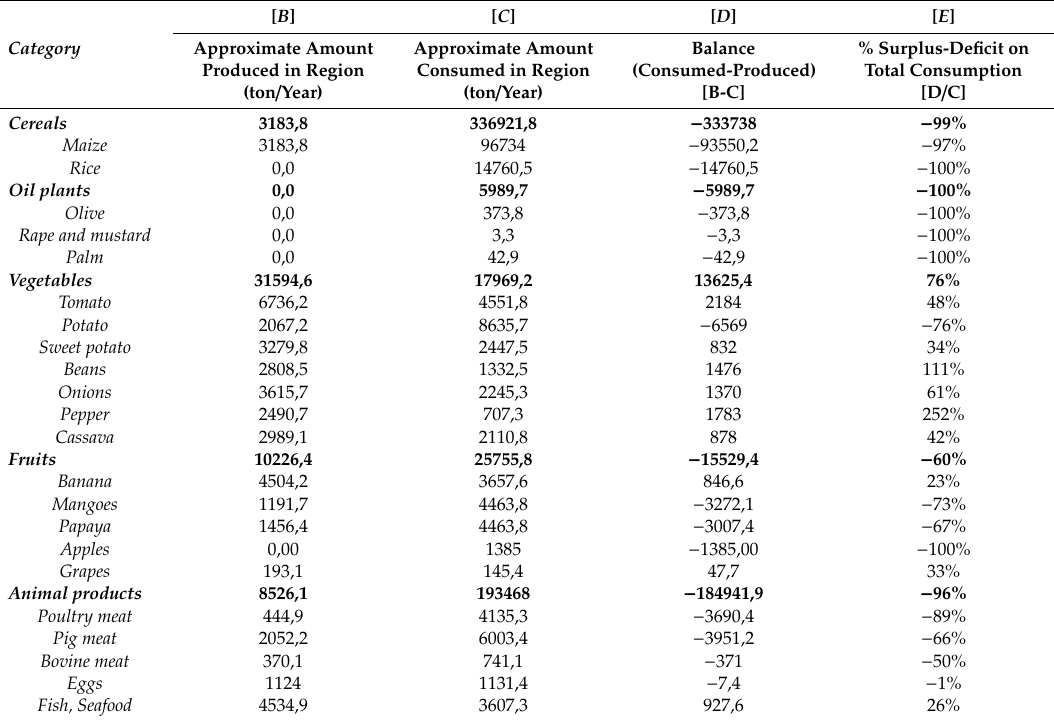
Table 2. Balance of production and consumption of relevant agricultural products in the region. [ B ] Category Balance % Surplus-Deficit on Approximate Amount Approximate Amount Consumed in Region (Consumed-Produced) Total Consumption Produced in Region [D / C] (ton / Year) (ton / Year) Cereals